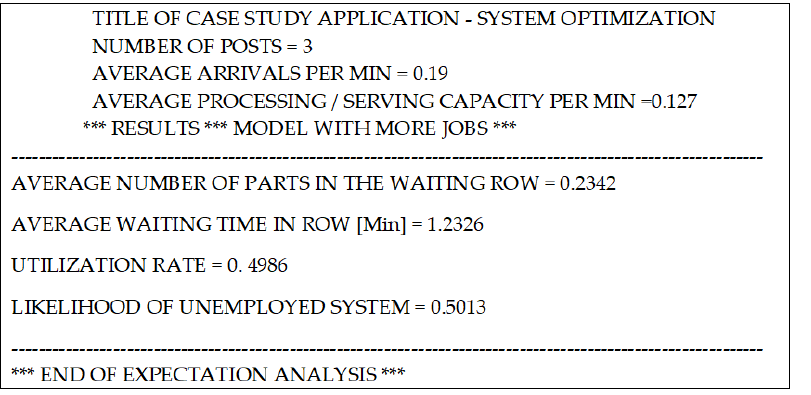
Figure 11. The optimal results for SOPT